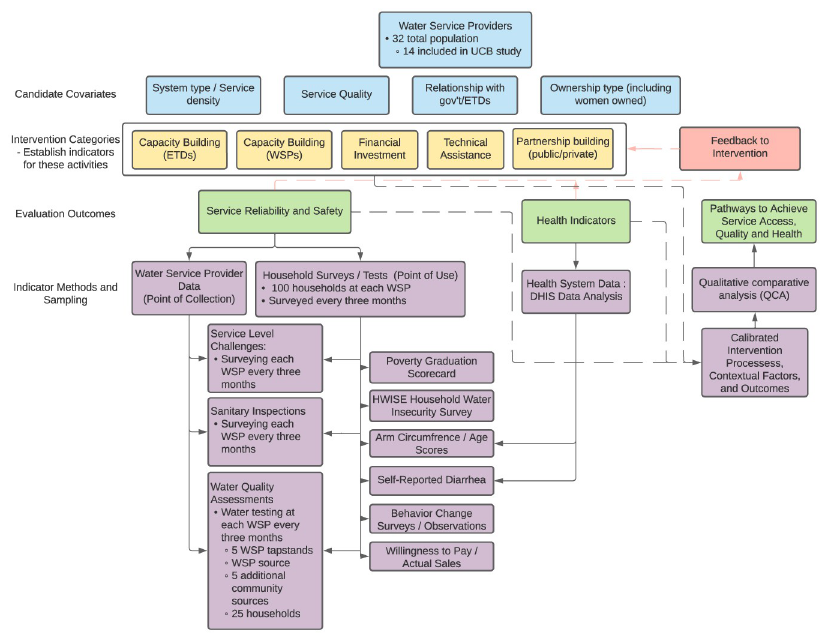
Fig 4. Research flowchart. Flowchart of research covariates, interventions, metrics, and primary evaluation outputs for the study design of the 14 WSPs in Kasai Oriental province.